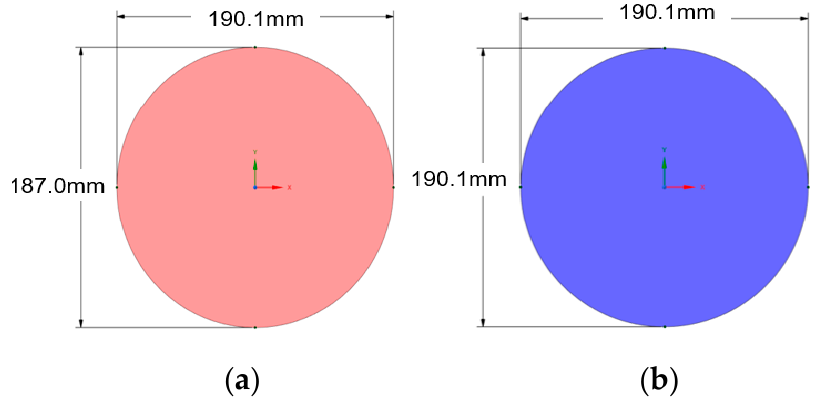
Figure 9. Dimensions of disc: ( a ) TOBV; ( b ) QOBV.